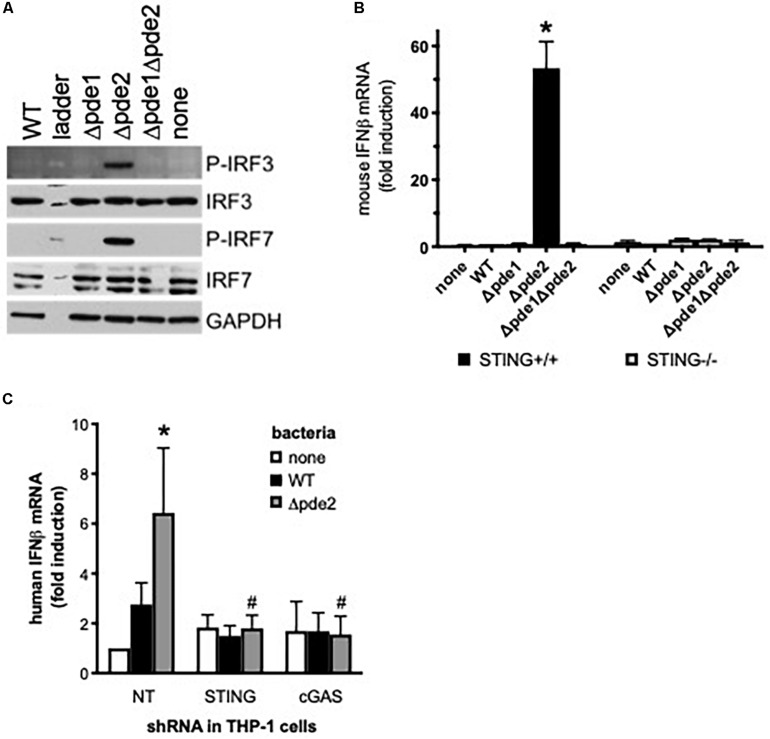
IFNβ expression elicited by phosphodiesterase 2 mutant pneumococci is mediated by the STING-cGAS-IRF3-IRF7 signaling pathway. (A) Relative contents of phosphorylated IRF3 and phosphorylated IRF7 protein were measured using immunoblot in cell lysates from mouse macrophage-like RAW264.7 cell cultures infected 2 h with the indicated bacteria. Relative contents of total IRF3 and IRF7 were measured for comparison, as well as GAPDH for loading control (image shown was from one experiment, representative of 2 independent experiments). (B) Relative induction of IFNβ mRNA was measured in parallel cultures of mouse macrophage-like RAW264.7 cells, one of which was deficient in STING due to gene targeting. Cultures were infected for 2 h with the indicated bacteria. Mouse IFNβ mRNA was measured and normalized to 18S rRNA using qPCR, and expressed relative to the cells infected by WT bacteria (N = 3 experiments). Asterisk (*) indicates P < 0.05 compared to WT. (C) Relative induction of IFNβ mRNA was measured in parallel cultures of human THP-1 cell cultures that were stably transduced with lentiviruses encoding shRNA that was non-targeting (NT) or which targeted STING or cGAS. THP-1 cells were matured to macrophage-like phenotypes using PMA before being infected 2 h with the indicated bacteria. Human IFNβ mRNA was measured and normalized to 18S rRNA using qPCR, and expressed relative to the uninfected cells transduced with NT shRNA (N = 5 experiments). Asterisk (*) indicates P < 0.05 compared to WT bacteria in cells transduced by the same shRNA, and hashtag (#) indicates P < 0.05 compared to NT shRNA-transduced cells infected by same bacteria.